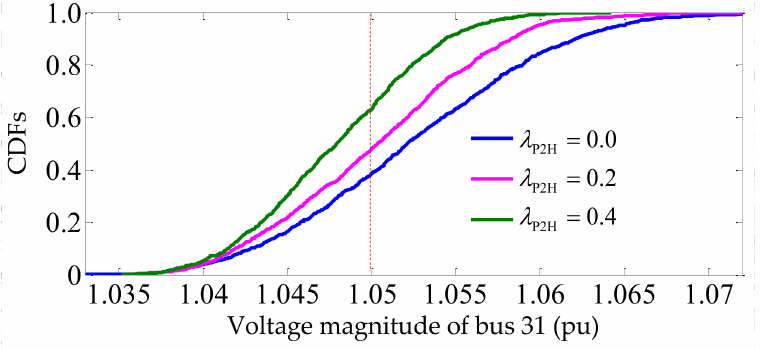
Figure 12. CDFs of voltage magnitude of bus 31.